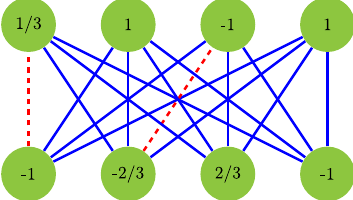
FIG. 5. The 8-qubit gadget used in the instance construction. The qubits (green circles) are arranged in a complete bipartite graph. Blue (red) lines correspond to ferromagnetic (antiferro- magnetic) Ising couplers with magnitude 1. The value of the local fields on the qubits are given inside the circles, with a negative value indicating a spin-up